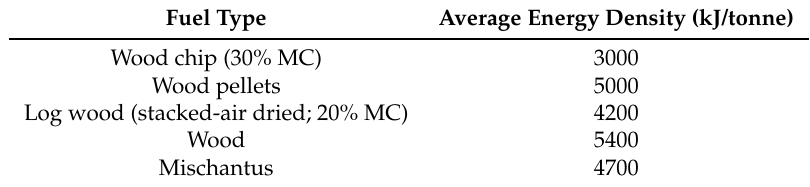
Table 5. Average densities of biomass solid fuels [32]. MC: moisture content.